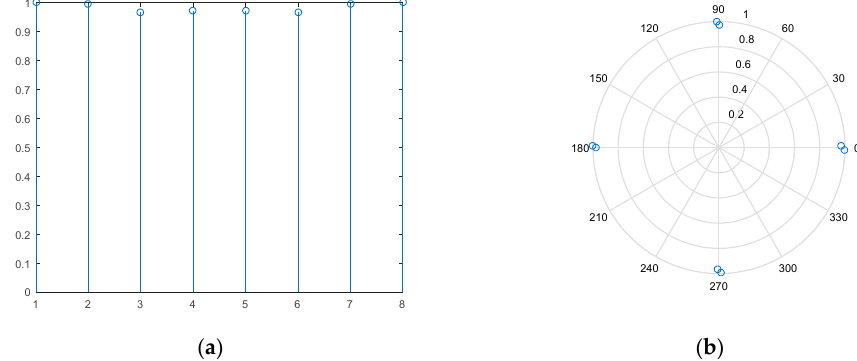
Figure 5. Illustration of linear relationship in element space with M = 8 ( a ) the amplitude diagram; ( b ) the phase diagram.